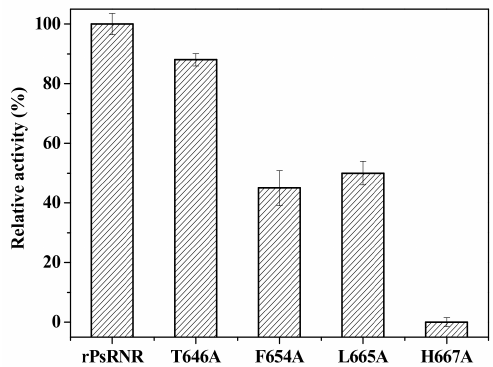
Figure 4. Measurement of the relative activity of the mutant rPsRNR generated by site-directed mutagenesis. The activity of the enzyme without mutation was defined as